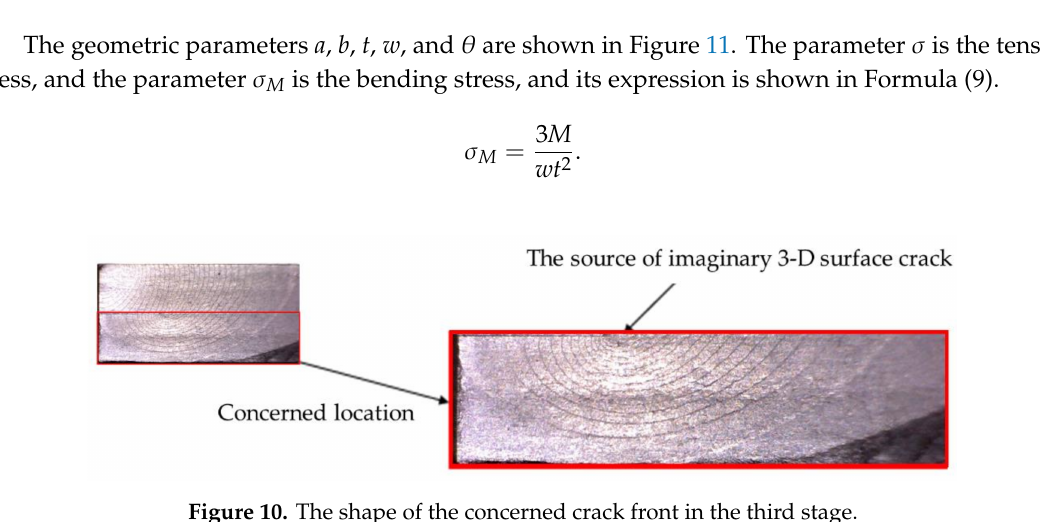
Figure 10. The shape of the concerned crack front in the third stage.